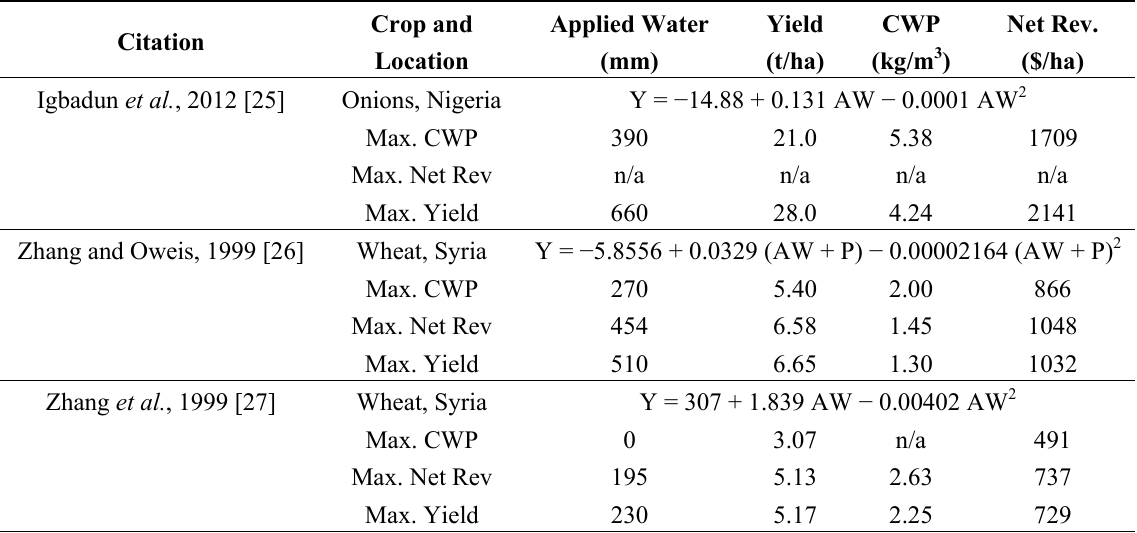
Table 1. Examples of water levels that maximize water productivity, net revenue, and yields, from empirical crop water production functions. Crop Citation